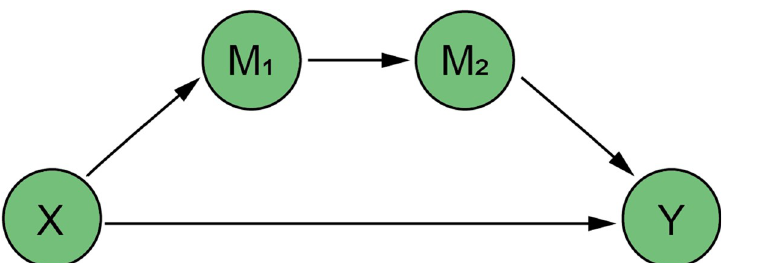
Fig 1. Chain-mediated path 1: Air quality, labor supply.